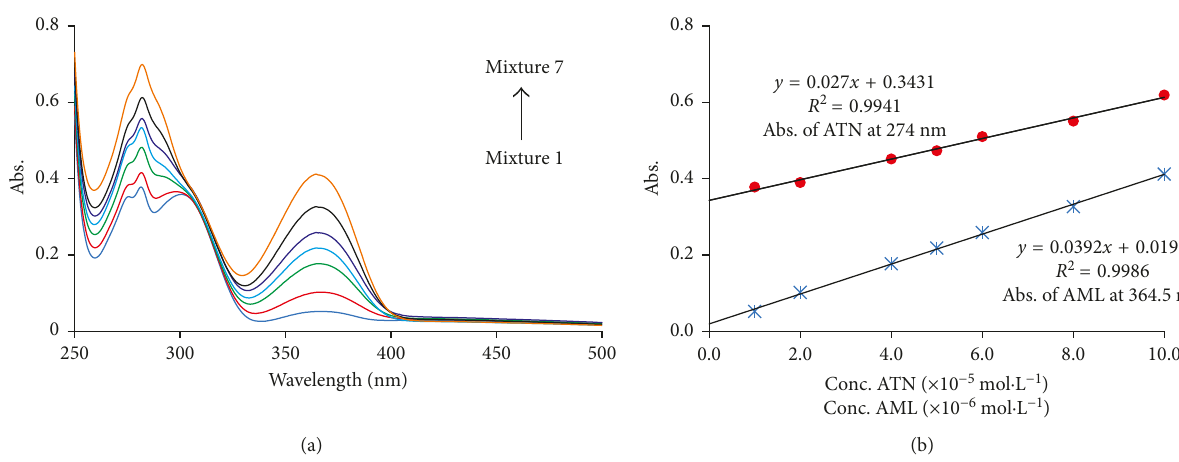
Figure 7: (a) Calibration spectra of different concentrations of ATN and AML mixture. From 1 to 7 mixtures, they are 1, 2, 4, 5, 6, 8, 5 mol 1 ATN with 1, 2, 4, 5, 6, 8, 10 L 10 10 · × and AML (measured at 364.5nm) using 100 µ L SH NPs and 50 mmol − −